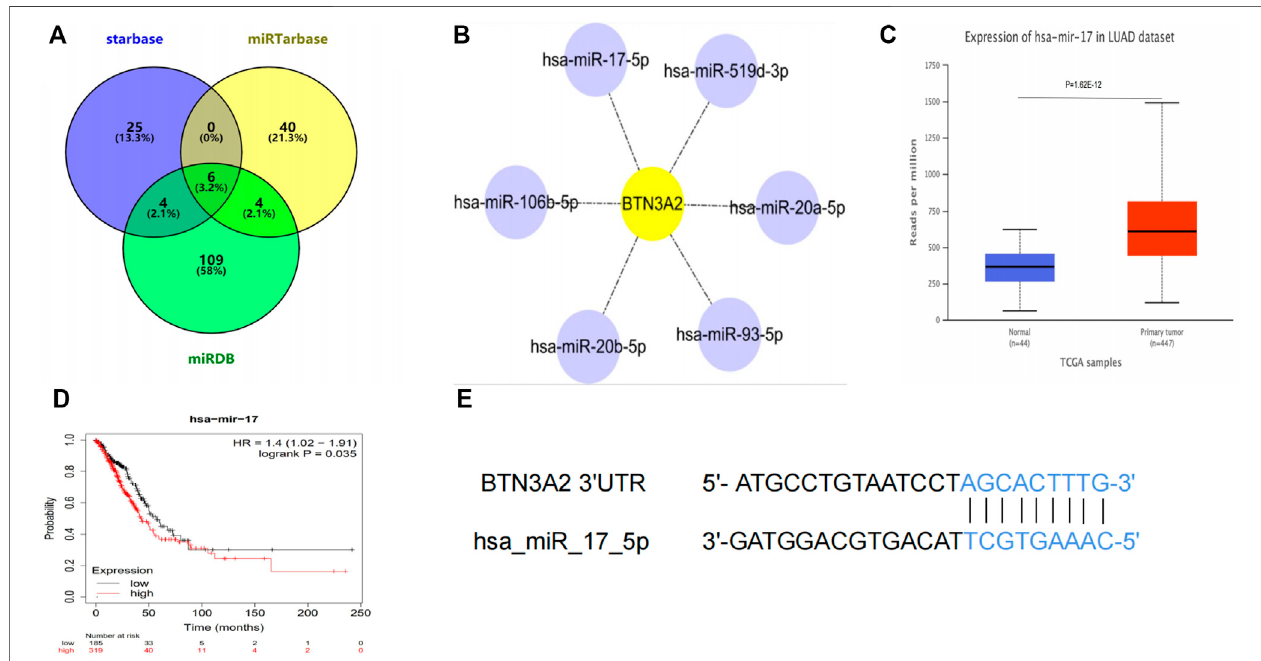
FIGURE 6 | hsa-miR-17-5p may be the target of BTN3A2. (A) Venn plot shows miRNA-target genes predicted by miRarbase, starbase, and miRDB. (B) miRNA- target regulatory network (Cytoscape). (C) Expression of hsa-miR-17 in the UALCAN database. (D) Survival curve of hsa-miR-17 in lung cancer by the Kaplan – Meier Plotter database. (E) Base pairing between hsa_miR_17_5p and the target site in the BTN3A2 3 ’ UTR predicted by miRDB and RNA22Sites.